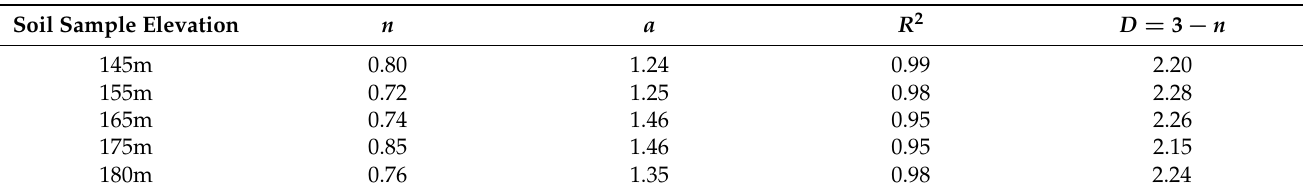
Table 1. Fractal dimension of soil with different elevations.